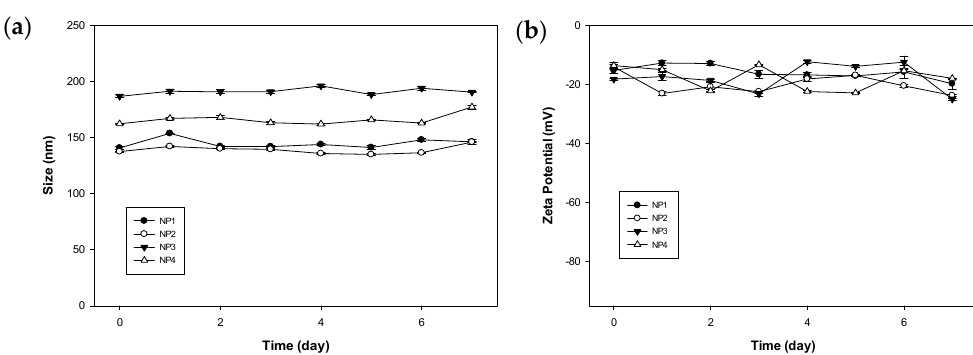
Figure 4. Storage stability of NPs at 4°C for one week. The size (a) and zeta potential ( ζ ) (b) values of NPs were monitored every day.